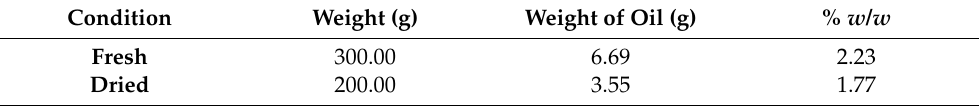
Table 1. Yield of essential oil from fresh and dried stem samples of C. gileadensis .